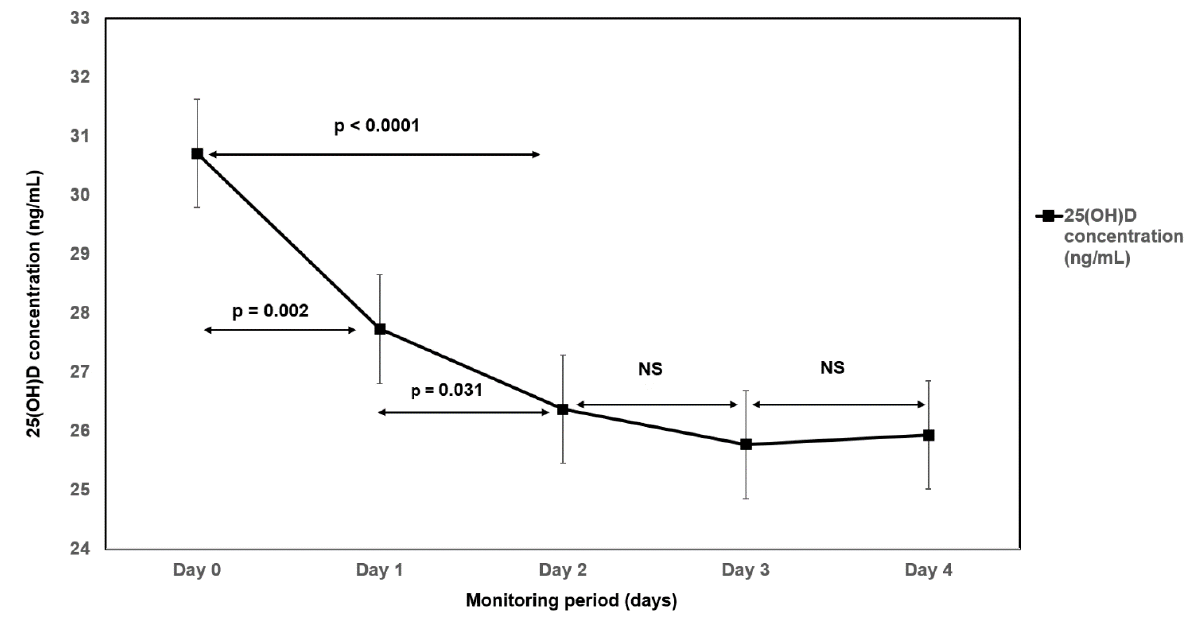
Figure 1. The evolution of serum 25-hydroxyvitamin D (25[OH]D) levels change during the study period.